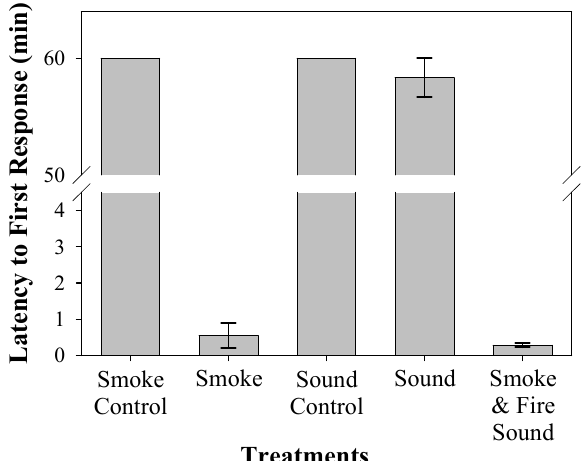
Figure 4. First response (i.e., movement or increased respiration) latencies of eastern red bats ( n = 15) exposed to different lab-based treatments. Bats that failed to have a first response were given a value of 60 min. There was a difference between treatments (Friedman p < 0.05). Latency to first response was shorter in the smoke treatment than the controls and fire sound treatments (Wilcoxon p < 0.05) and showed no difference when compared to smoke and fire sound combination and the smoke treatment (Wilcoxon p > 0.05).